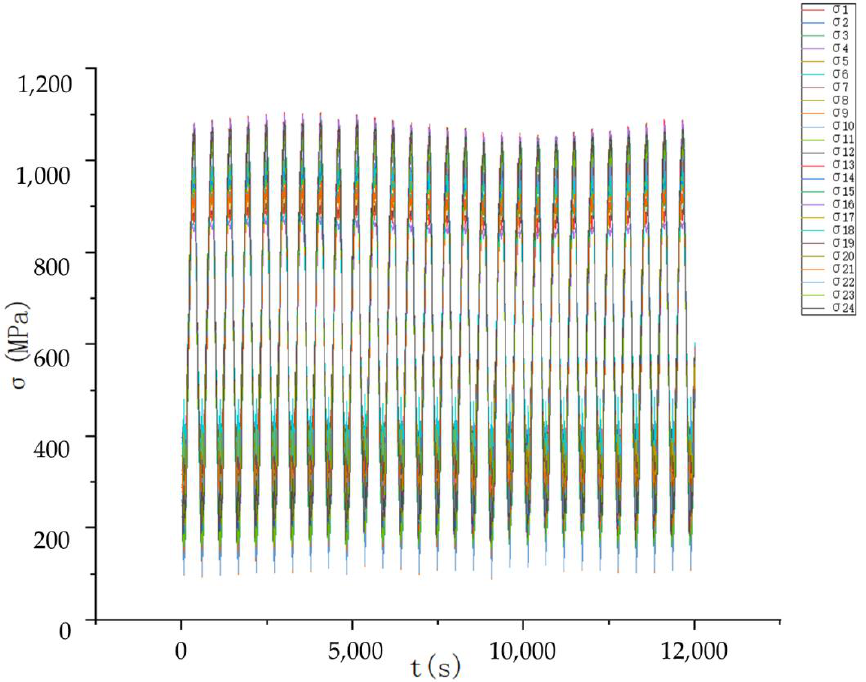
Figure 18. Stress changes at each weld measuring point.